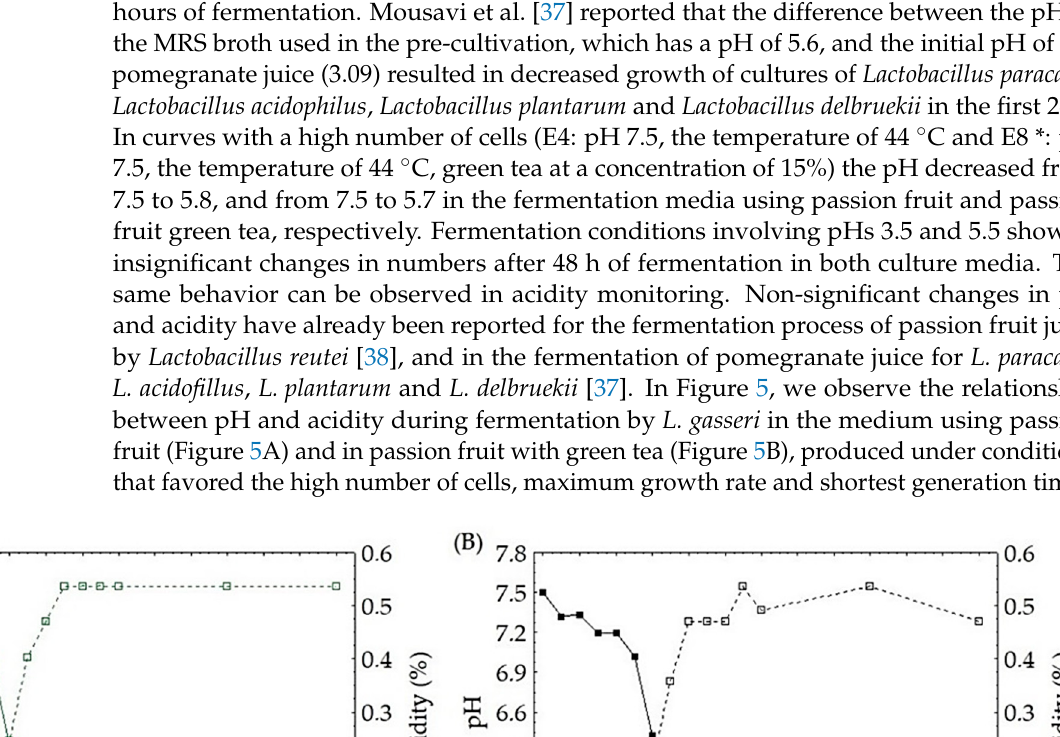
Figure 6. Monitoring of soluble solids with respect to cell concentration in the best fermentation conditions of passion fruit juice ( A ) and passion fruit with green tea ( B ).